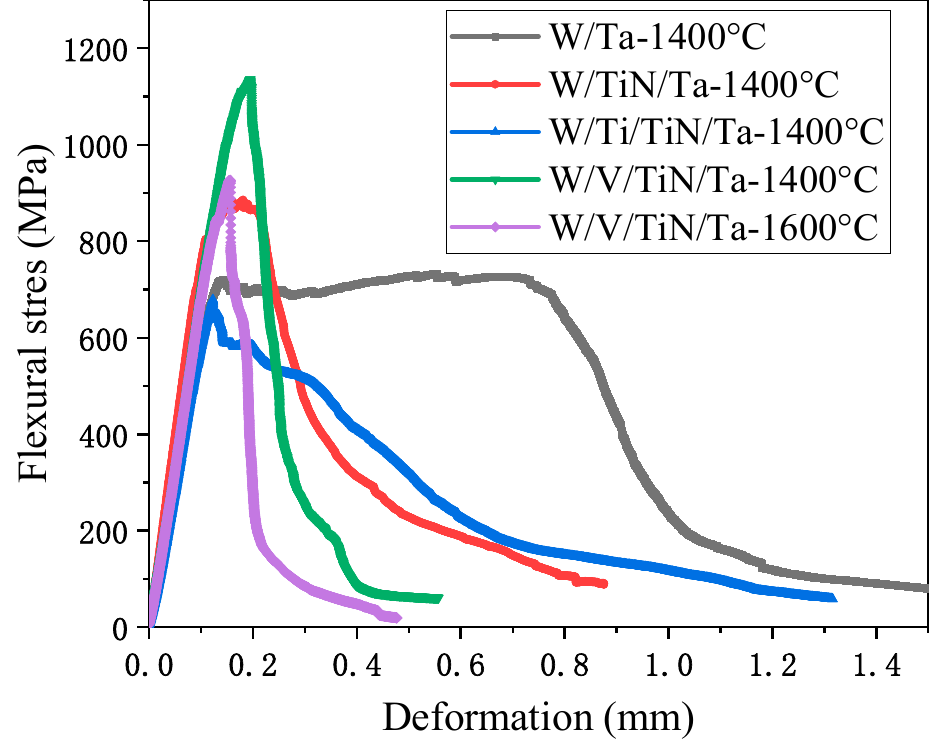
Figure 10. Three-point bending strength-displacement curves of W/M/TiN/Ta-laminated composites joined at 1400 °C and 1600 °C. Table 7. Three-point bending properties of W/M/TiN/Ta composites joined at 1400 °C.